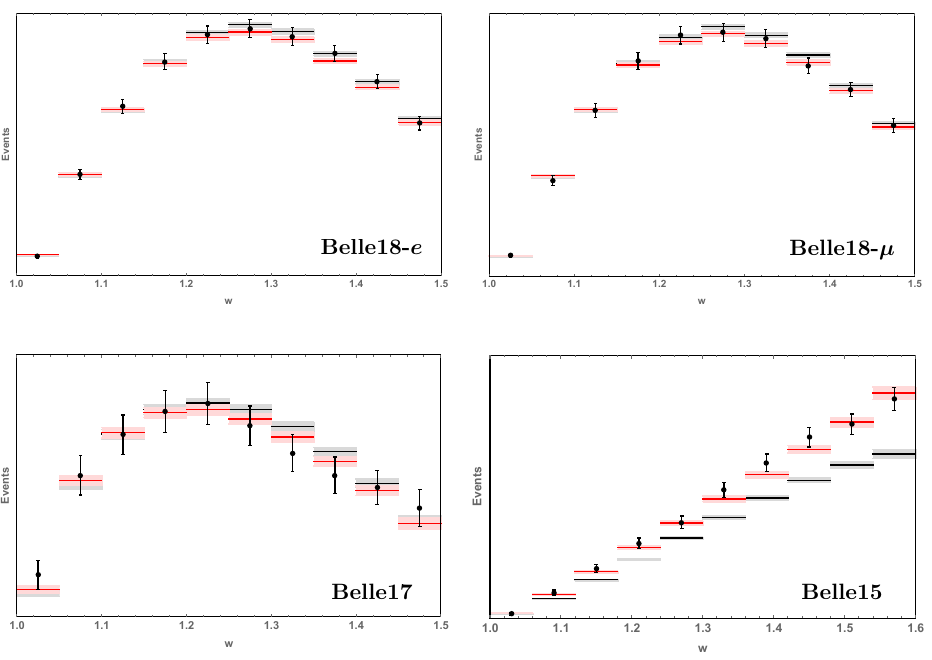
Figure 3 . Binned decay distributions with respect to w with the comparisons between data and the (cid:12)t results from the SM (2 = 1 = 0) [red] and SM (3 = 2 = {) [gray] scenarios. for ( (1) ; f 2 ). In turn, R { R correlations are obtained as 0 : 15, 0 : 03, 0 : 81, ; f 2 ; f 2 D D (cid:3) 1 2 3 F (cid:0) (cid:0) (cid:0) and 0 : 57 for SM (2 = 1 = 0), SM (3 = 2 = 1), SM+ V (2 = 1 = 0), and SM+ V (3 = 2 = 1), respectively. 2 2 (cid:0) In (cid:12)gures 3{6, we also show the binned decay distributions with respect to ( w; cos (cid:18) ‘ ; cos (cid:18) ) with the comparisons between data and the (cid:12)t results in the SM (2 = 1 = 0) [red] and V ; (cid:31) SM (3 = 2 = {) [gray] scenarios, in order to visualize the improvement on the (cid:12)ts. Note that the distributions for Belle17 (Belle18) are those of the decay rates (folded signal events) as explained in the main